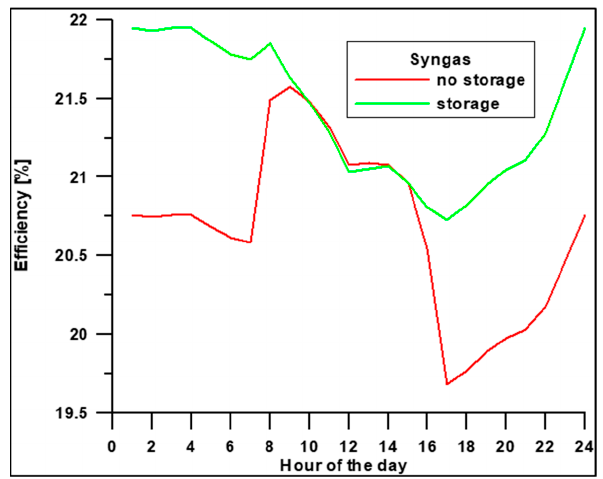
ffi ciency versus day hours (Syngas fuel). Energies 2020 , 13 , x FOR PEER REVIEW